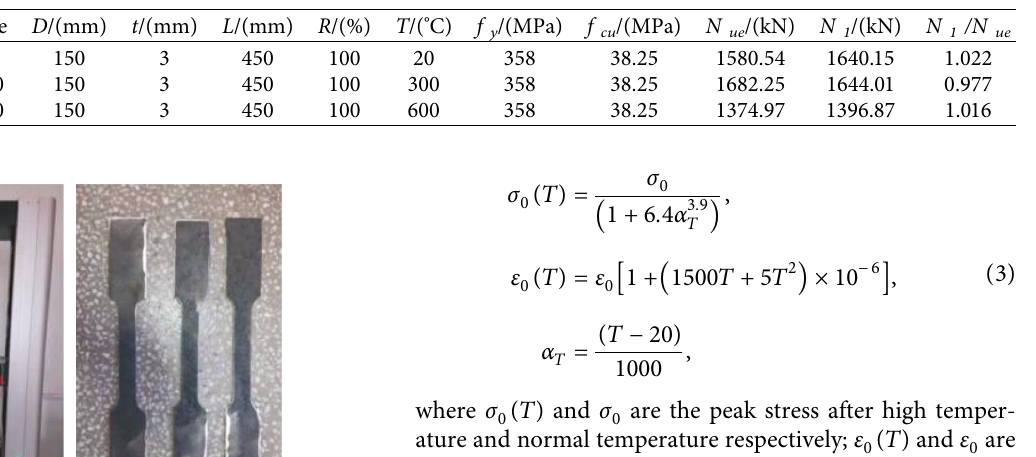
Table 1: Specific parameters of each specimen in the test.